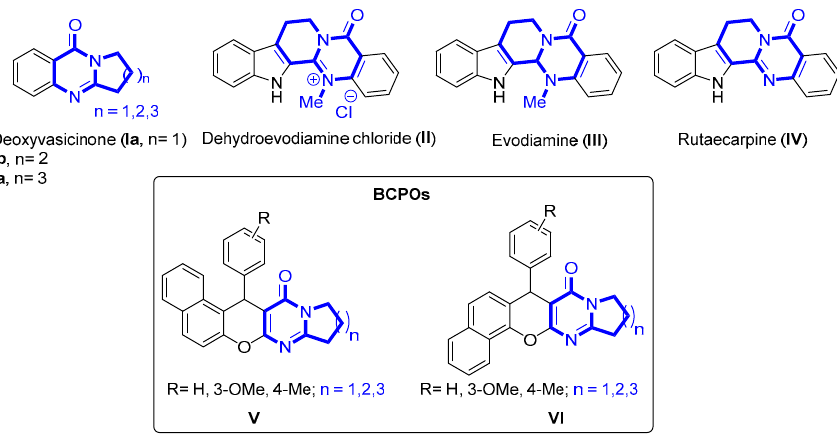
Figure 1. The quinazolinone alkaloids Ia – IV and designed BCPOs V and VI .